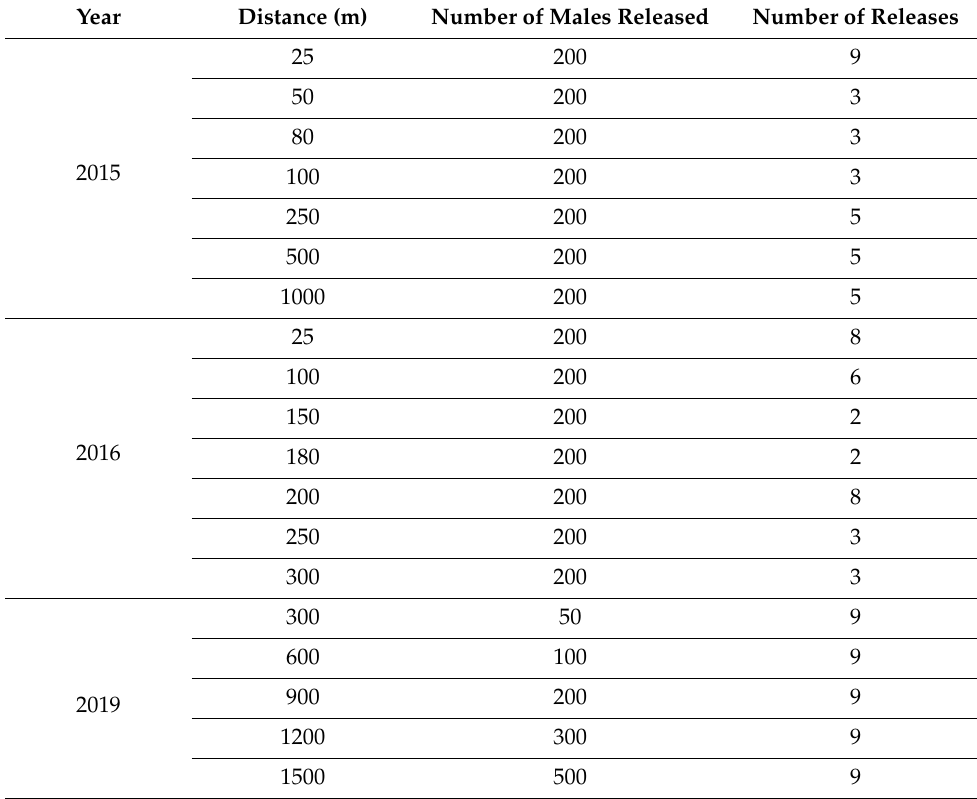
Table 1. Releases of male gypsy moths at various distances from pheromone-baited traps in plots with single-release, multiple-trap design (Figure